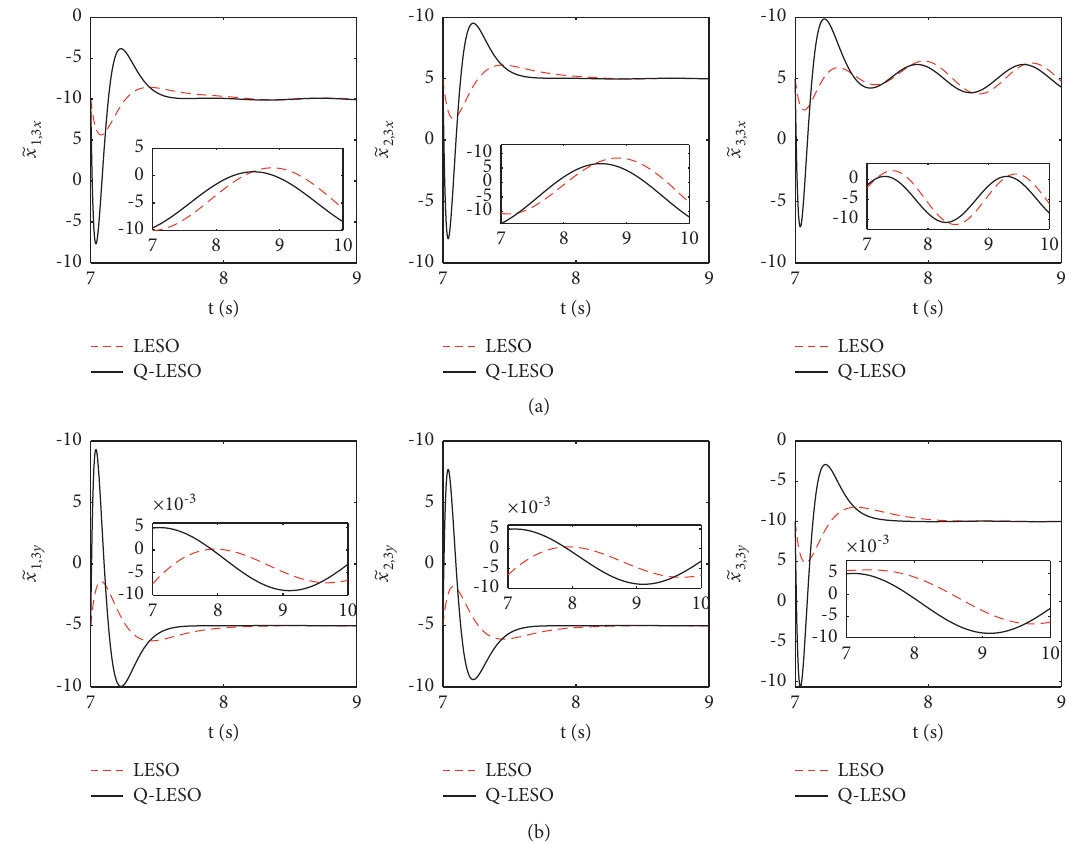
Figure 12: The disturbance estimation error 􏽥 x i, 3 in Case B(a) The disturbance estimation error of the x -direction of the i th agent i (b) The disturbance estimation error of the y -direction of the i th agent i � 1, 2, 3.